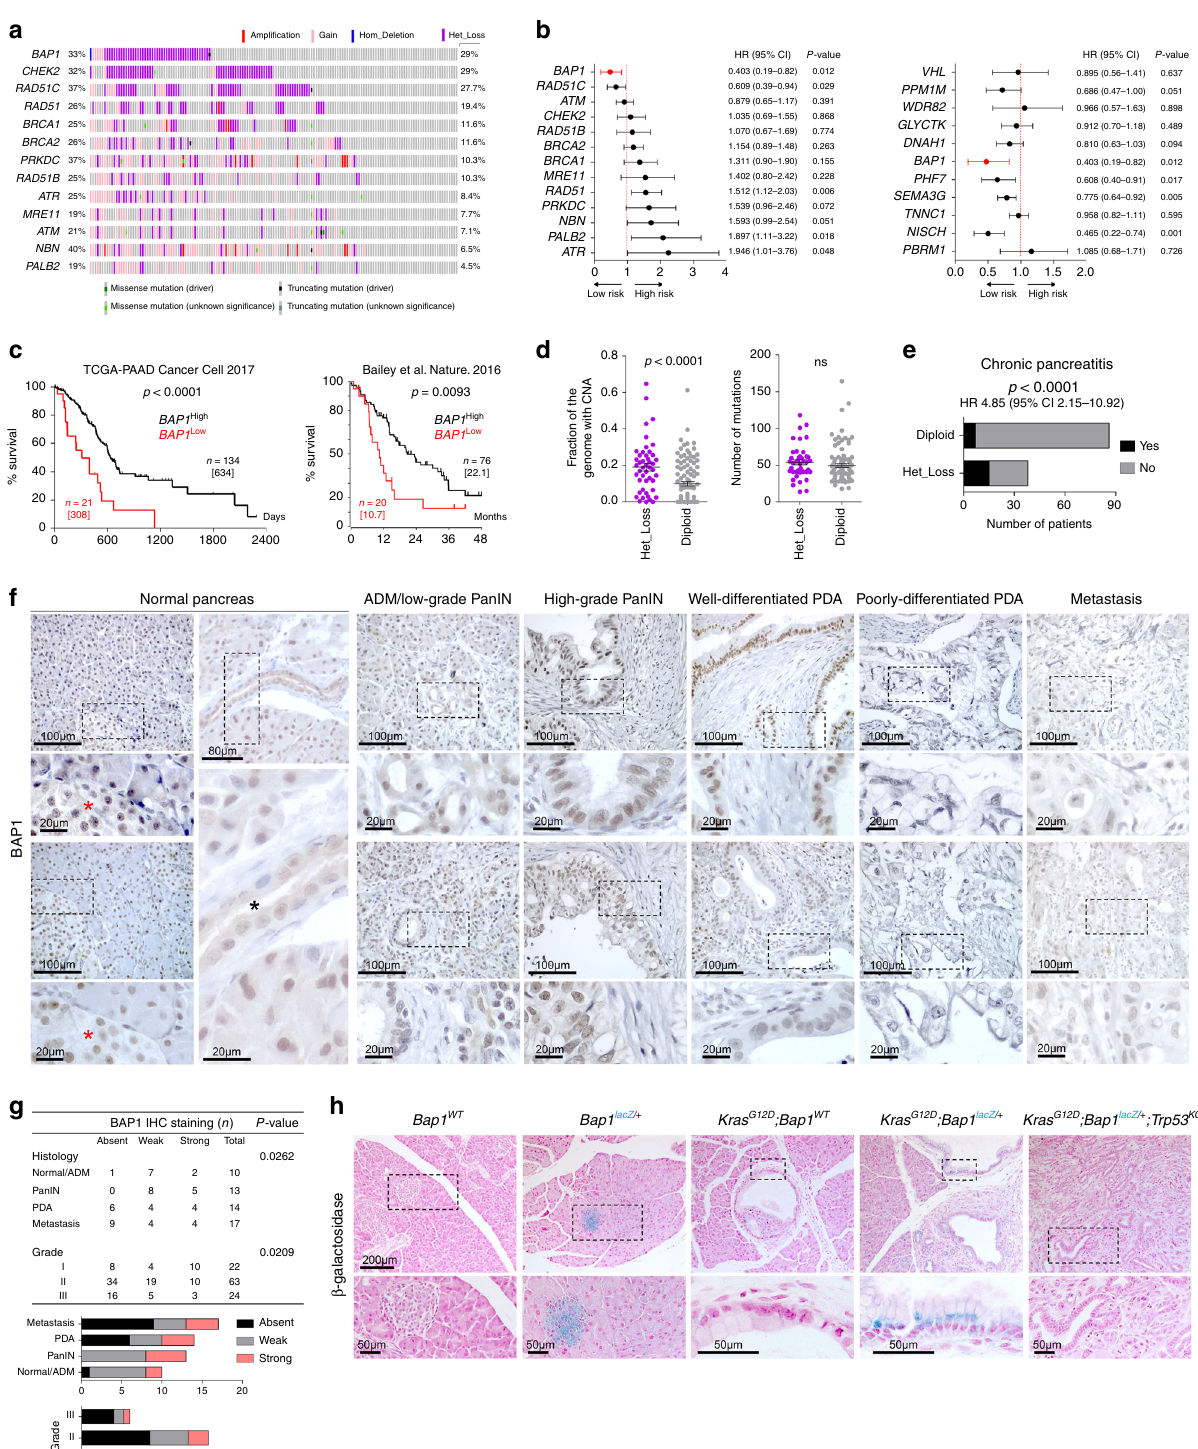
exhibited normal endocrine and exocrine pancreas histology and showed widespread expression of β -galactosidase (Supplementary Fig. 1l). On the contrary, β -galactosidase in older mice was largely con fi ned to islets with a weak mosaic staining of acinar and ductal cells. Consistent with the expression pattern observed in human (Fig. 1f), β -galactosidase staining in murine pancreata showed an increase in premalignant lesions driven by Kras G12D , but no